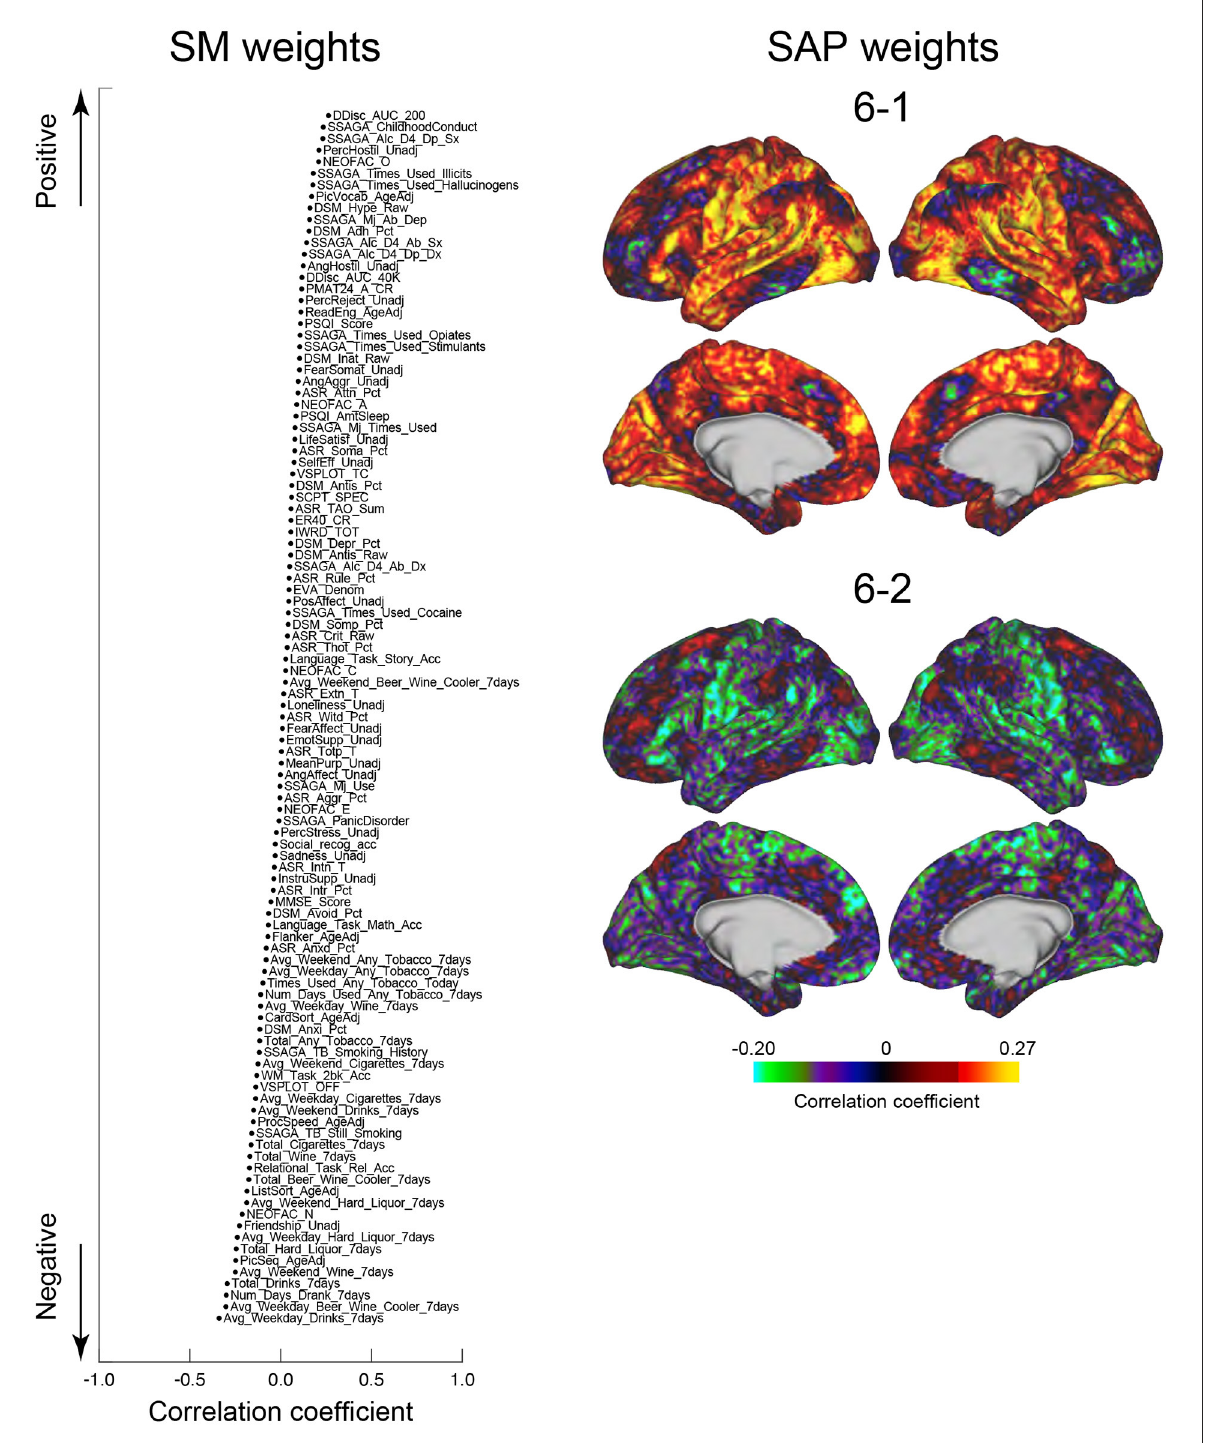
FIGURE7 CCA analysis of SMs and Cluster 6. Formats are similar to those in Figure